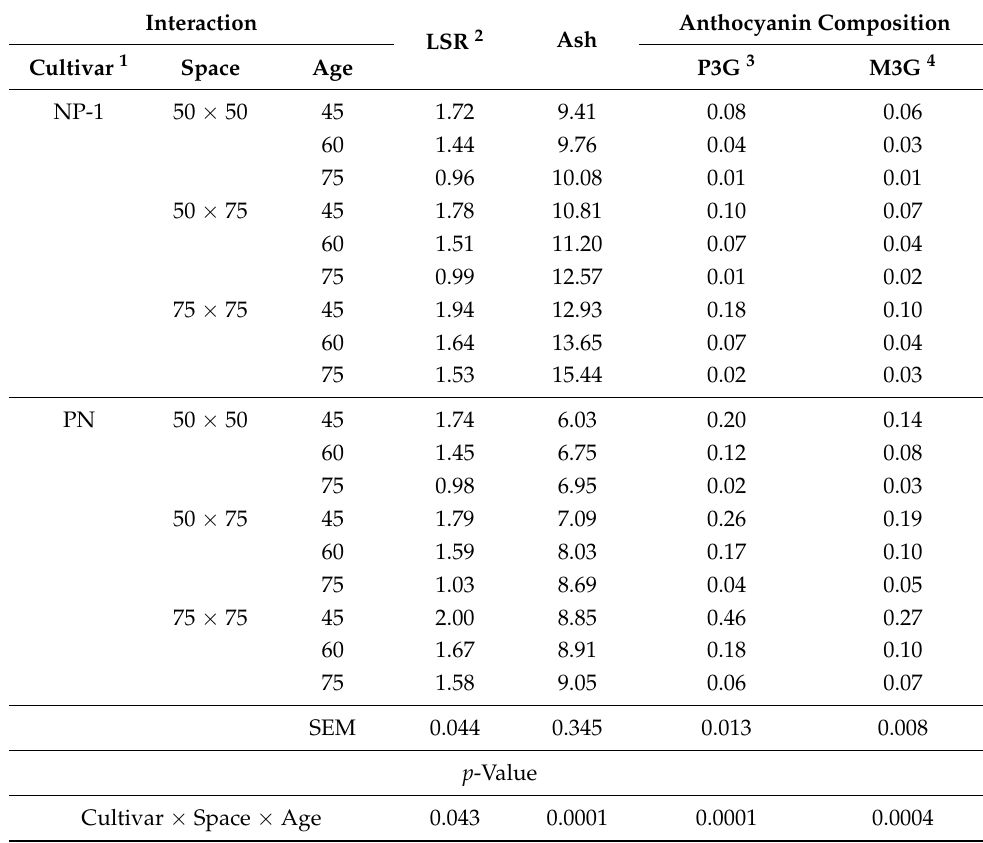
Table 1. The effect of the interaction of cultivar × plant spacing × harvesting age on the parameters of fresh Napier grass.